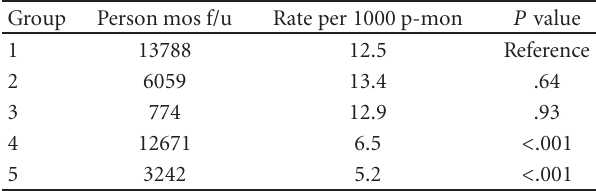
Table 2: Acute cellular rejection rates per 1000